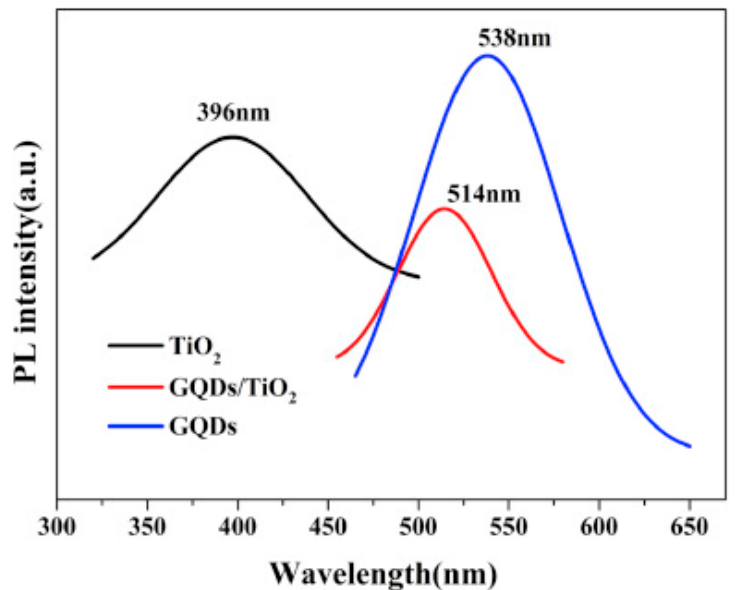
Figure 21. PL spectra of GQDs, TiO 2 , and TiO 2 /GQDs. Reprinted with permission from reference [167].